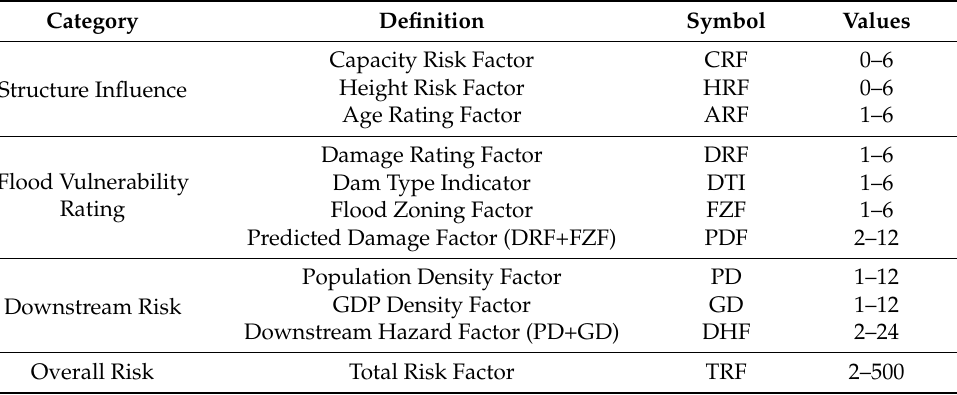
Table 7. Definition of all risk factors.